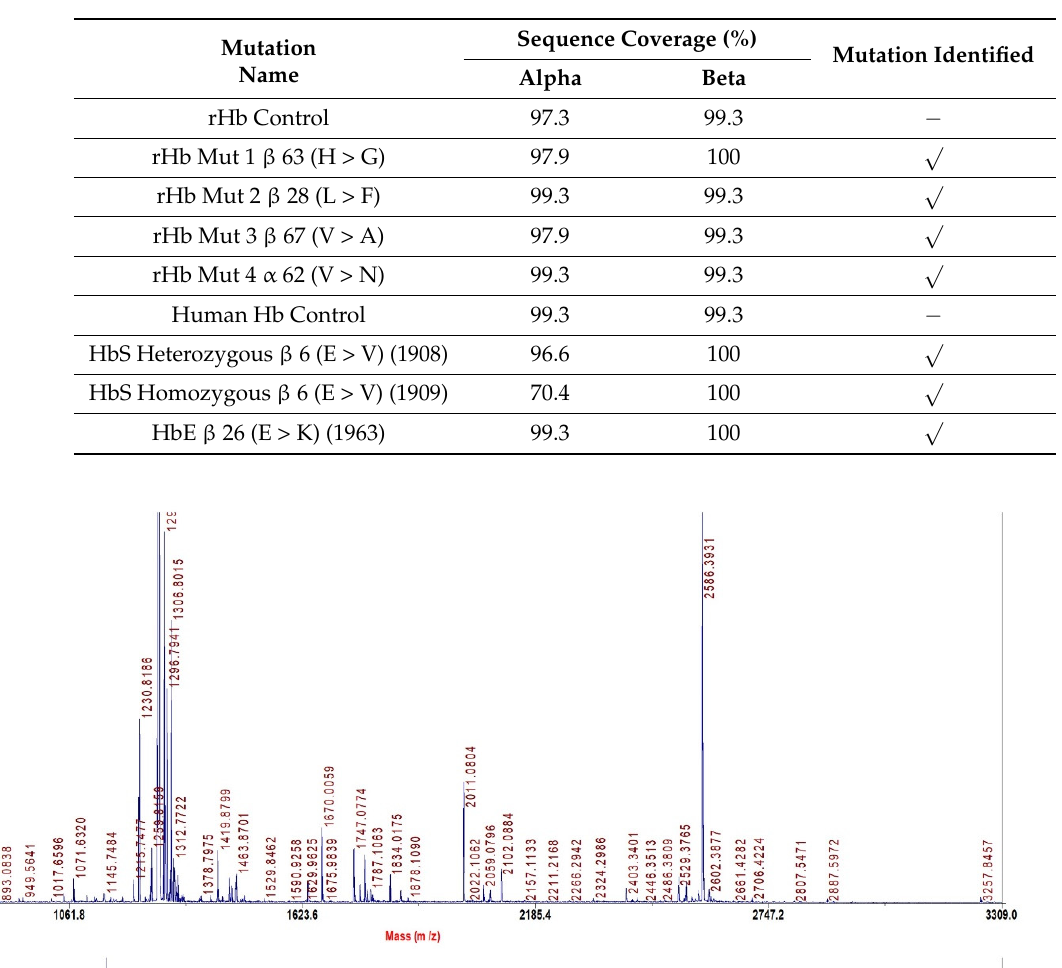
Table 4. Sequence coverage for rHbs and human Hb variants with TFE mediated digestion in LC coupled with MALDI MS/MS.